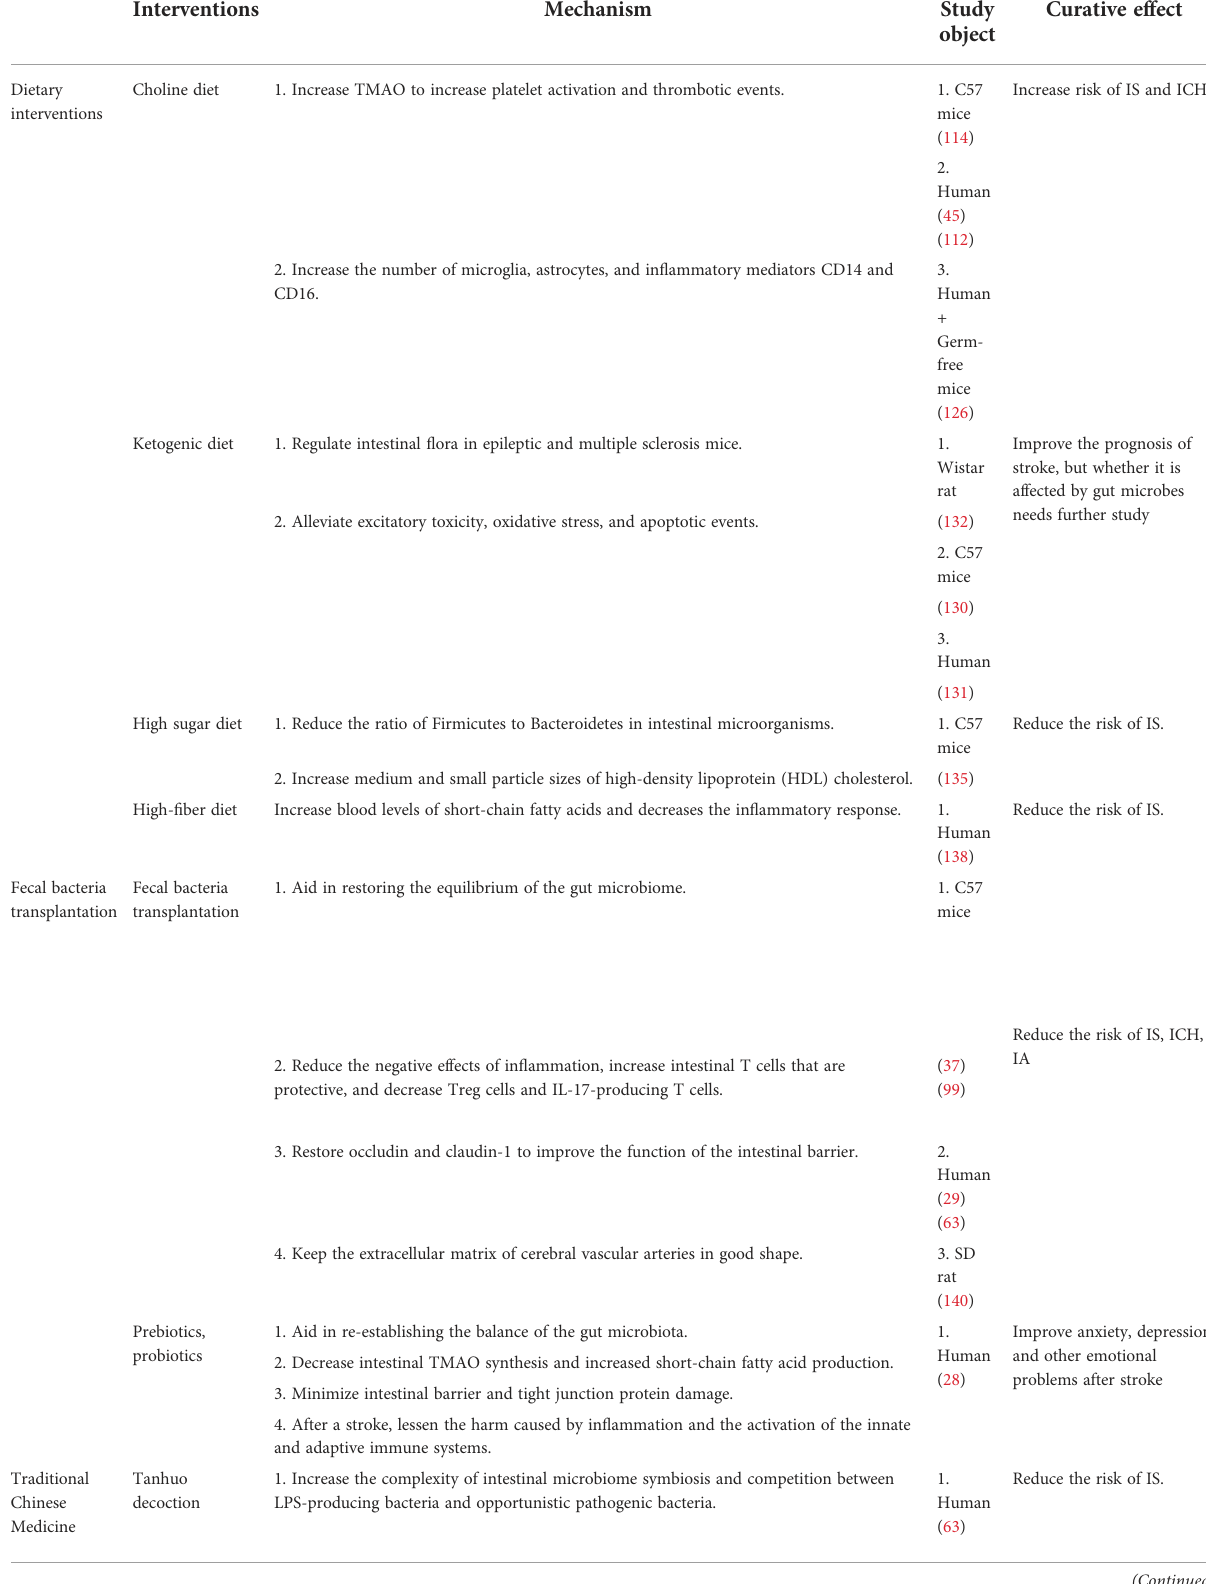
TABLE 1 Interventions, in fl uence mechanisms and ef fi cacy of gut microbes in cerebrovascular